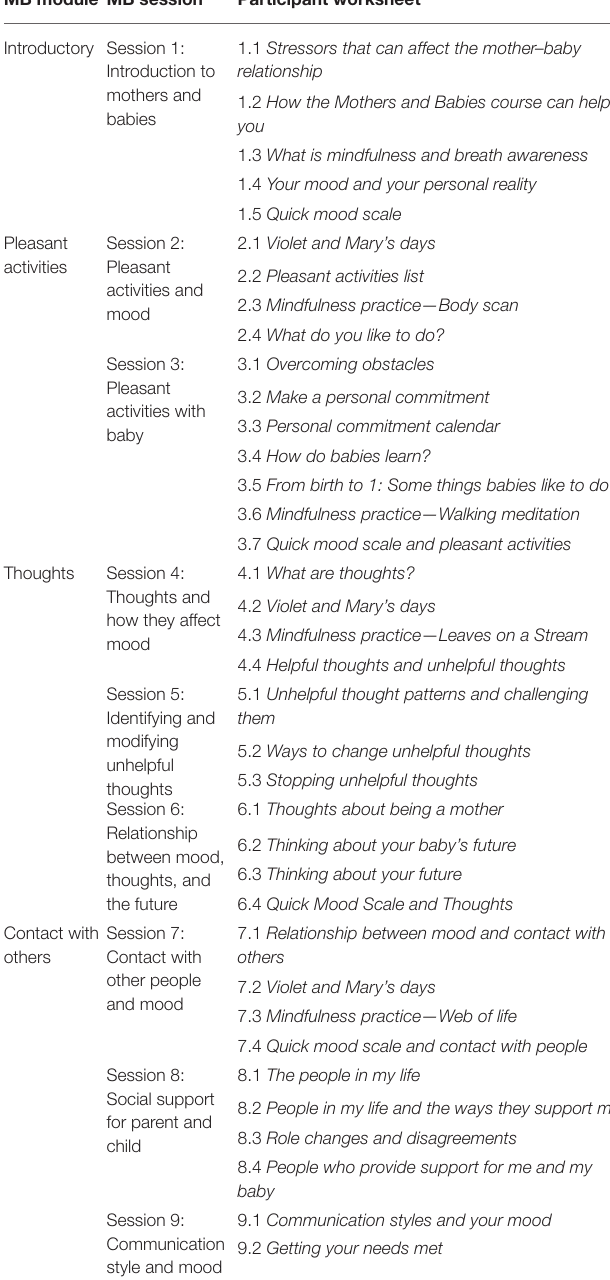
TABLE 1 | Mothers and babies intervention